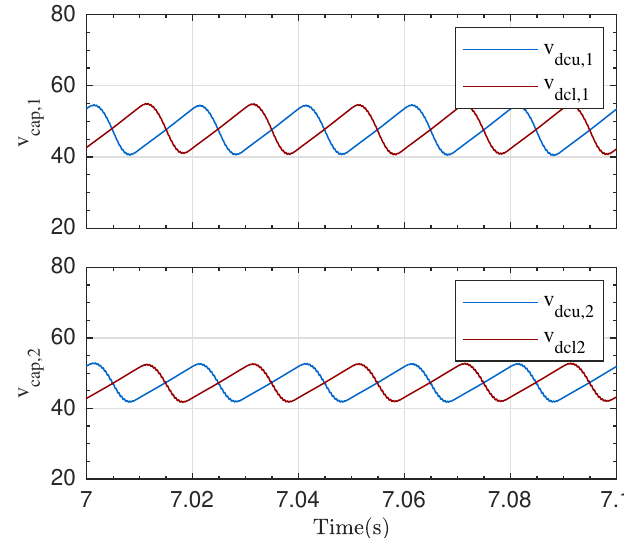
Figure 8. Steady-state operation of capacitor voltages for each power